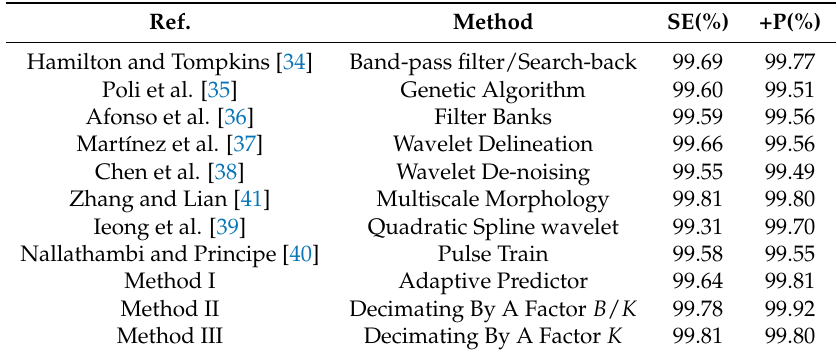
Table 3. Performance of QRS detectors on the MIT-BIH Arrhythmia Database. SE stands for sensitivity, while +P stands for positive predictivity. N/R stands for Not Reported.